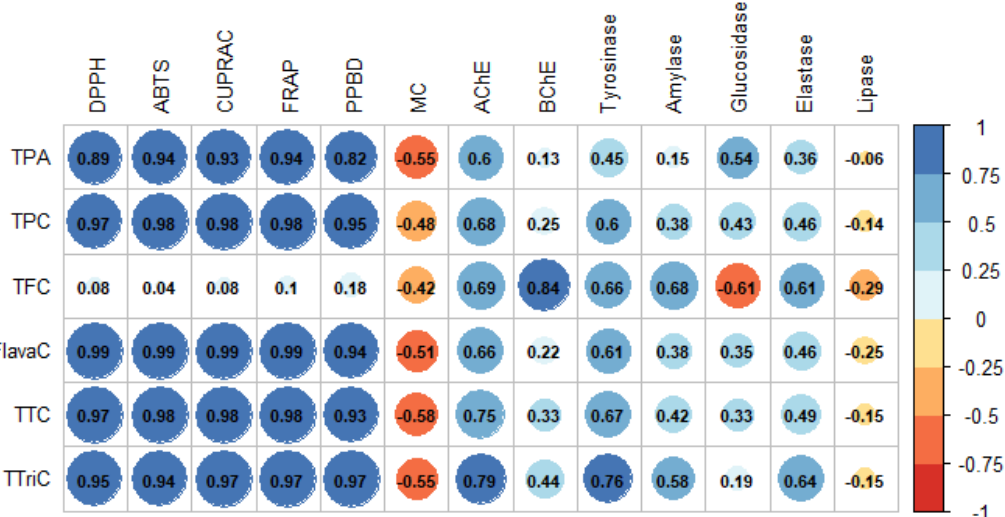
Figure 2. Pearson correlation between bio compounds quantified and biological activities ( p < 0.05).